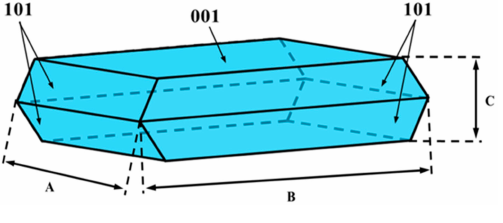
Figure 2. HRTEM images of TiO 2 materials used in the present study: ( a ) TiO 2 -1, ( b ) TiO 2 -2, ( c ) TiO 2 -3.